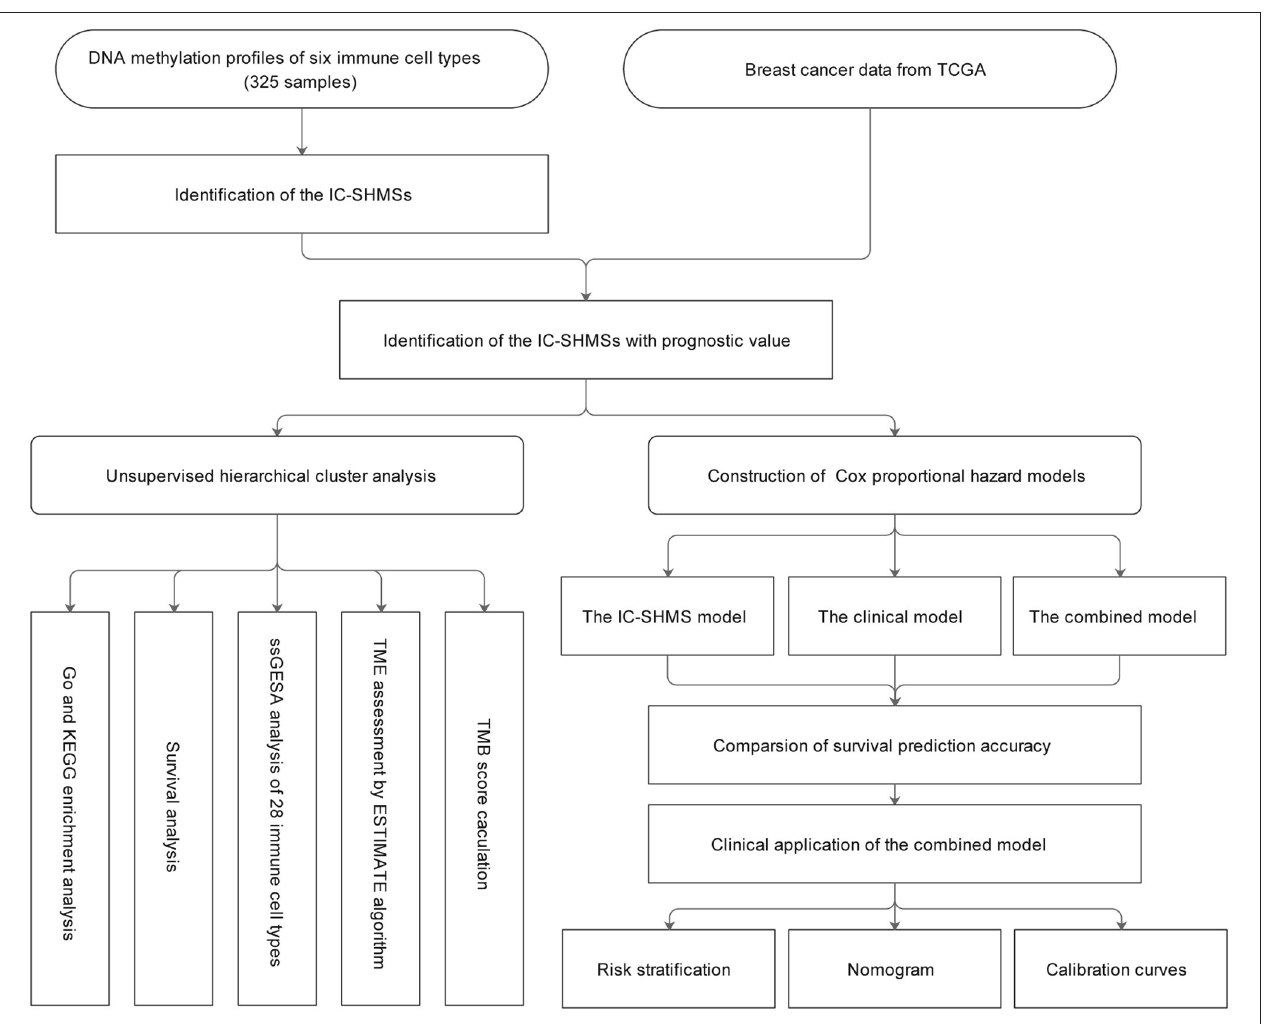
FIGURE 1 | Workflow chart. IC-SHMS, immune cell-specific hypermethylation signatures; Go, gene ontology; KEGG, Kyoto encyclopedia of genes and genomes; ssGSEA, single-sample gene set enrichment analysis; TME, tumor microenvironment; TMB, tumor mutation